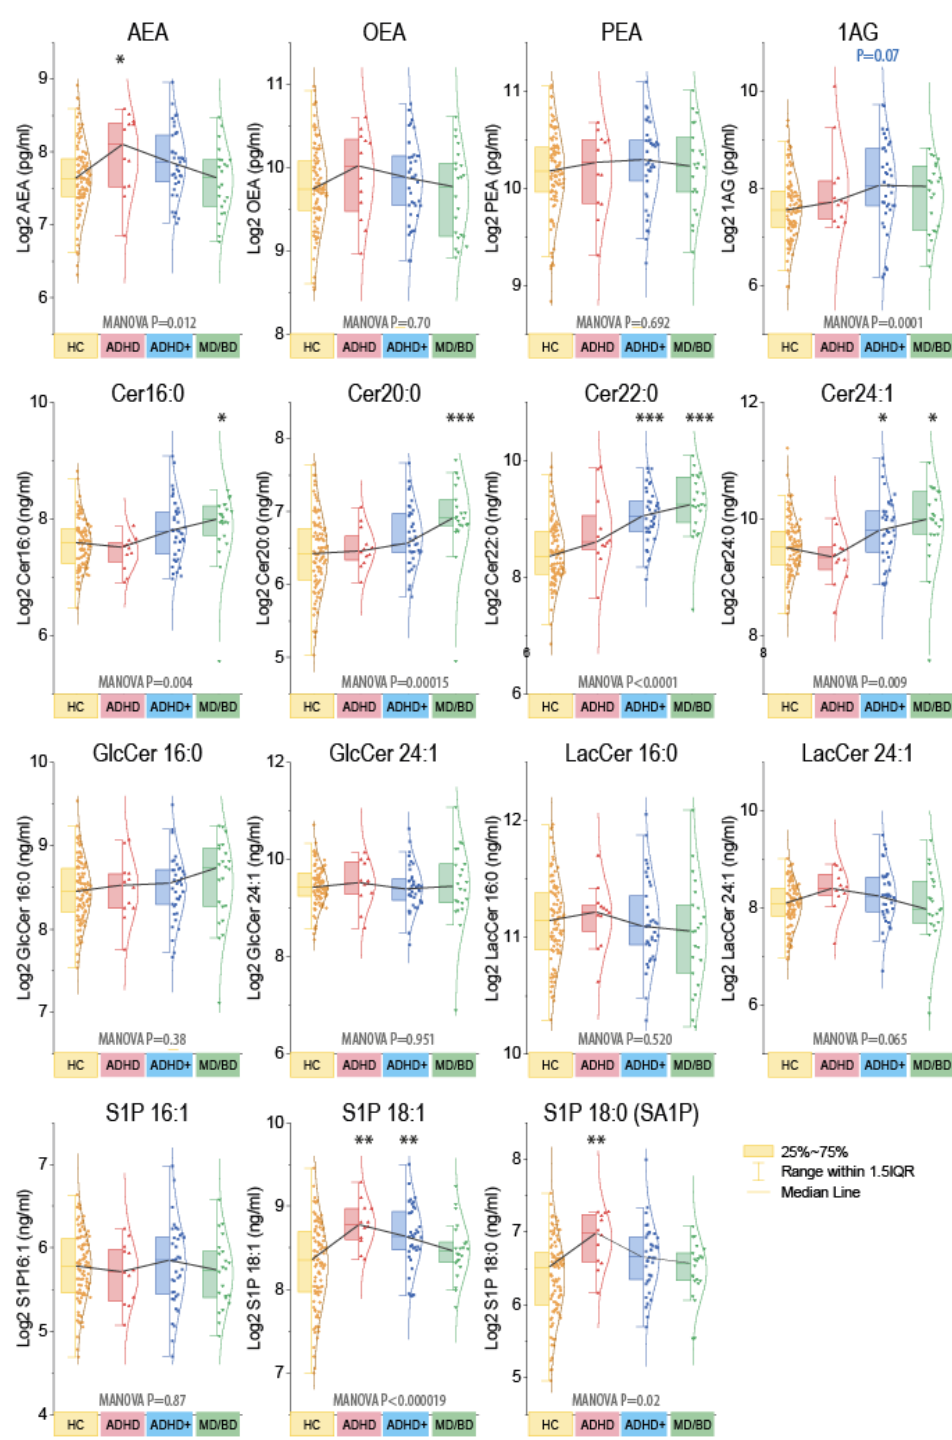
Figure 2. Grouped plasma concentrations of endocannabinoids and ceramides. The box plots show the interquartile range (IQR). The black line connects the medians. The scatters are the subjects, and the whiskers show the range within 1.5 × the IQR. The Gauss curves show the distribution. The data are log2 transformed because lipids were log-normally distributed. Endocannabinoids are pg/mL, sphingoid bases, and ceramides ng/mL. Because of the impact of sex for endocannabinoids (Supplementary Figure S2), data were compared with MANOVA for the factors “group” X “sex” and subsequent posthoc for the group using an adjustment of alpha according to Dunnett, i.e., versus HC. Asterisks indicate significant differences versus HC, * p <0.05, ** p <0.01, *** p <0.001. Samples sizes: n = 12 attention-deficit/hyperactivity disorder (ADHD), n = 37 ADHD with comorbidity (ADHD+), n = 22 major depression of bipolar disorder (MD/BD), n = 98 healthy controls